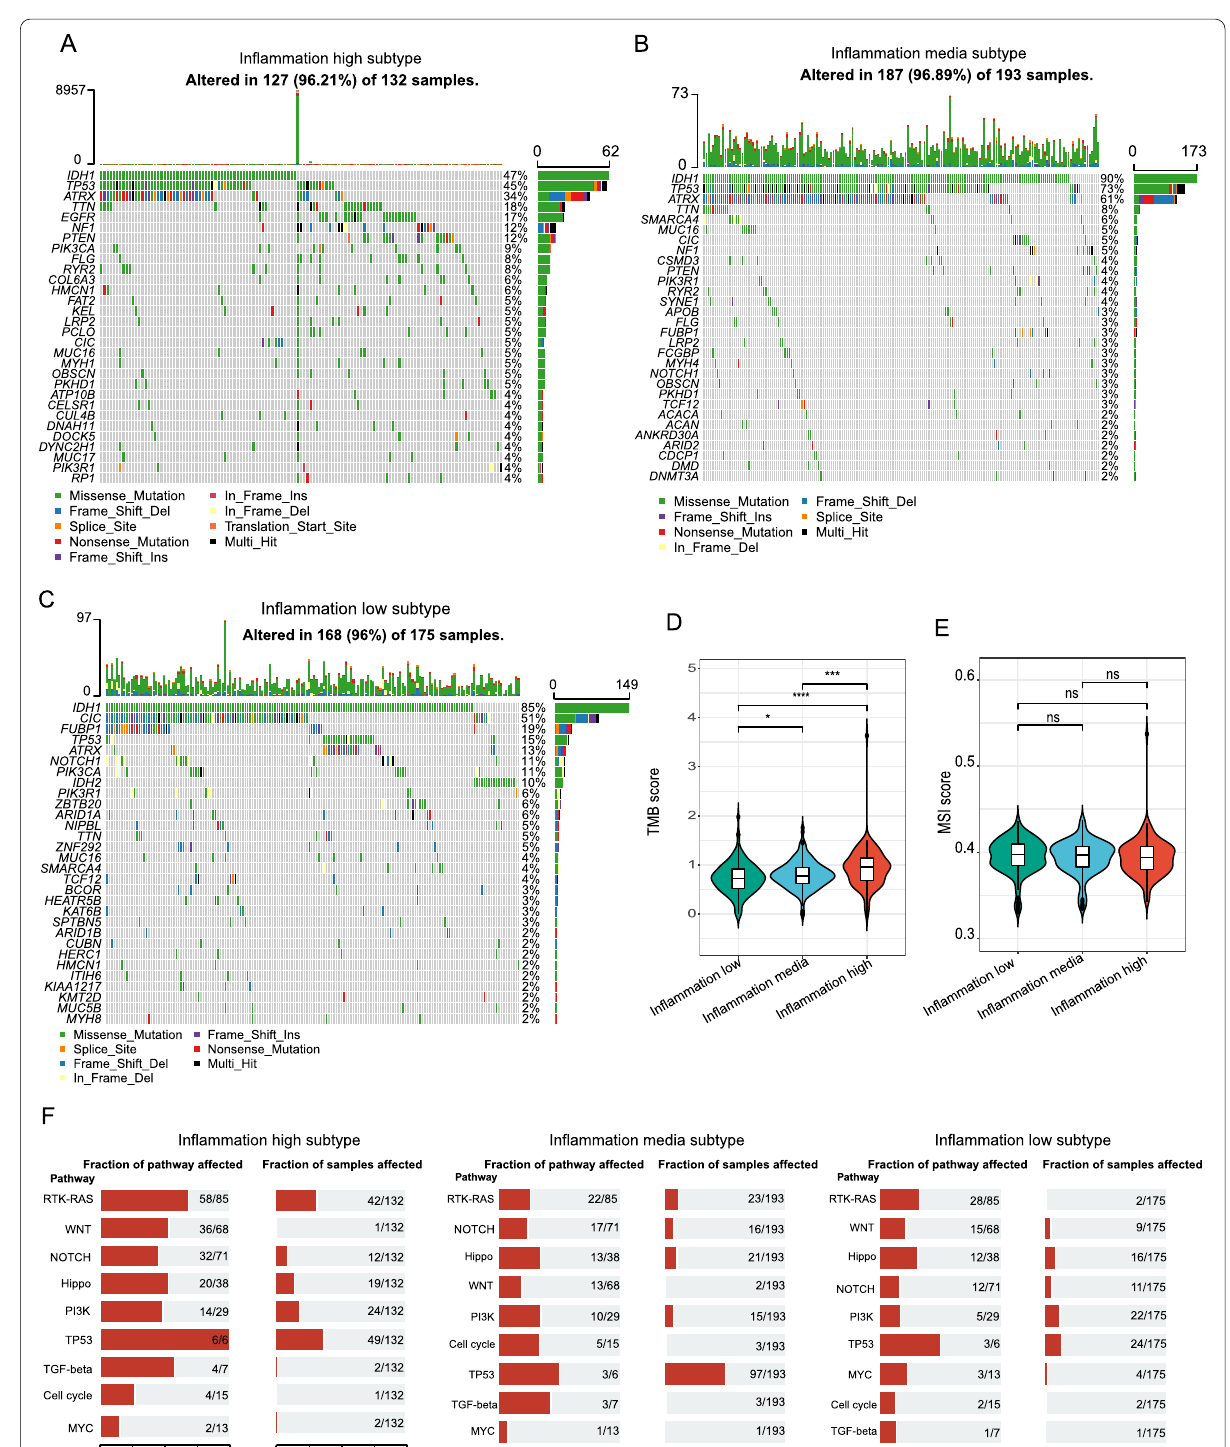
Fig. 5 Comparison of somatic mutations among different LGG subtypes. A–C Oncoprint visualization of the top 30 most frequently mutated genes in inflammation high subtype ( A ), inflammation media subtype ( B ), and inflammation low subtype ( C ). D and E Violin plots presenting the TMB score ( D ) and MSI score ( E ) of these subtypes. F The mutation frequencies of nine common oncogenic pathways in each of these three